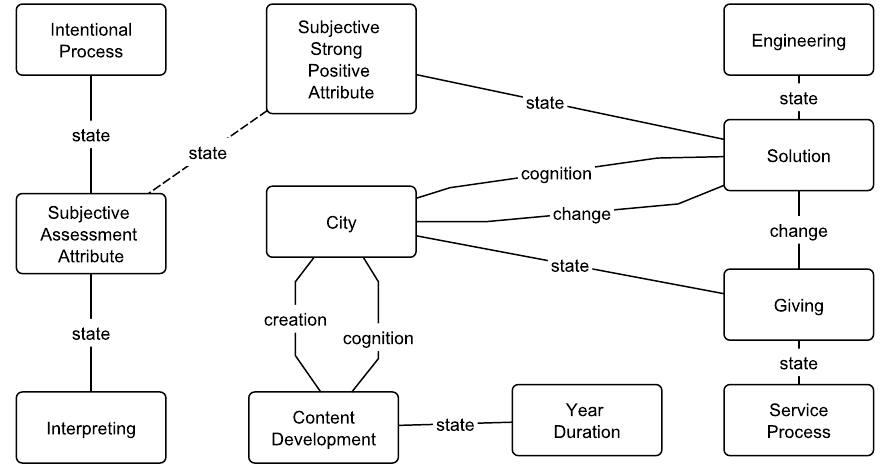
Figure 3. Semantic network generated for the sentence shown in Section 3.2.1. Each noun in the sentence was processed and mapped into a SUMO concept while verbs were used to connect SUMO